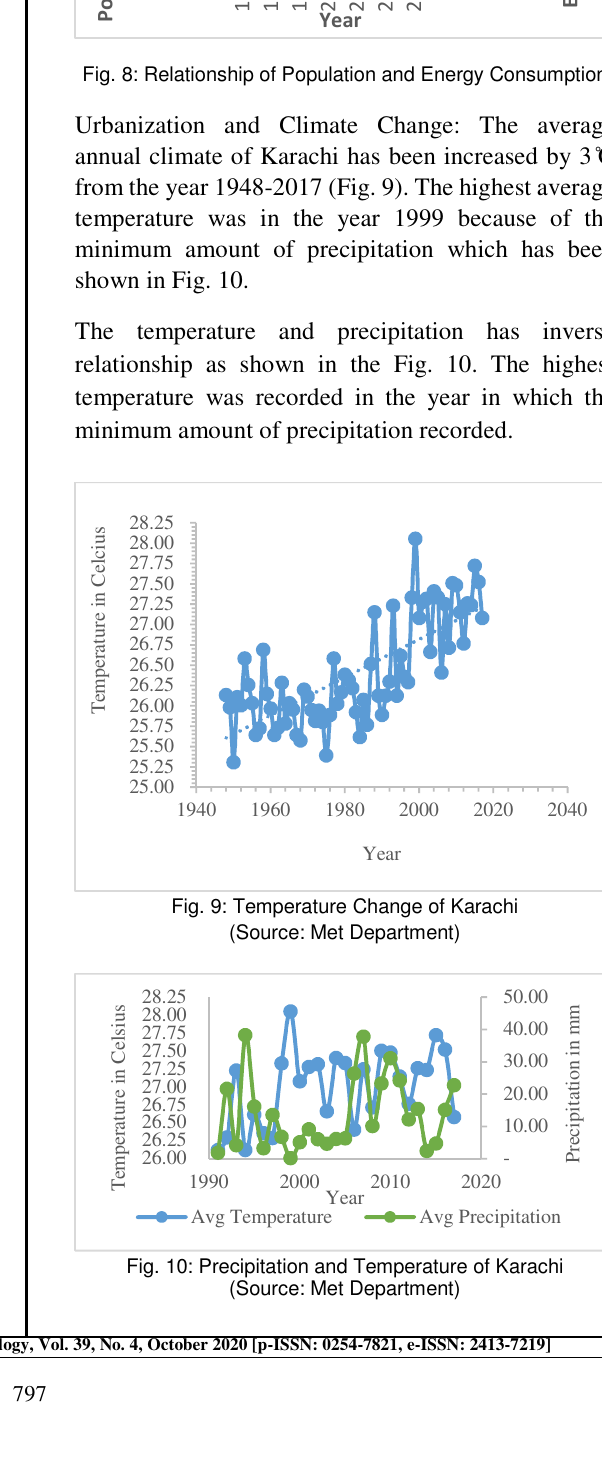
Fig. 10: Precipitation and Temperature of Karachi (Source: Met